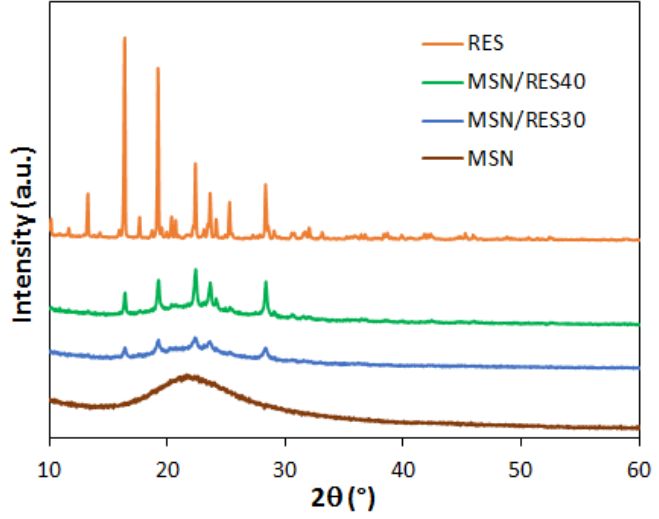
Figure 4. Wide angle XRD pattern of bulk RES, pristine MSNs, and RES-loaded MSNs.